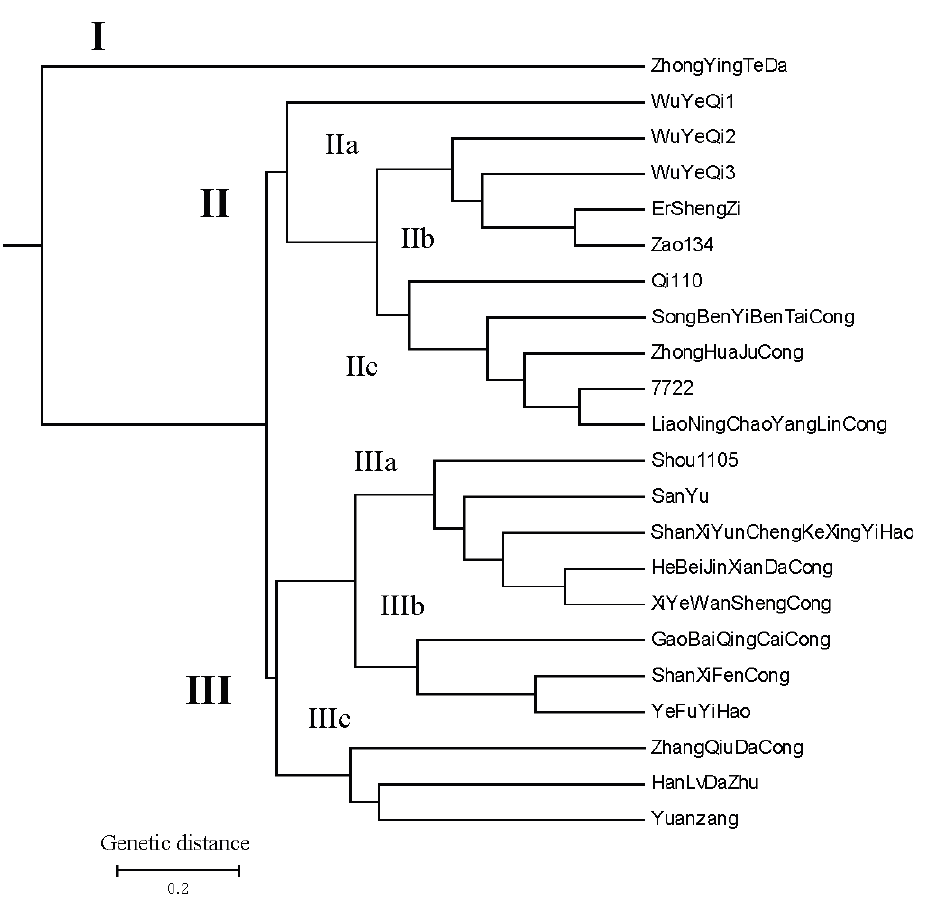
Figure 2. Dendrogram of 22 Allium accessions derived from UPGMA analysis of 22 highly polymorphic SSR